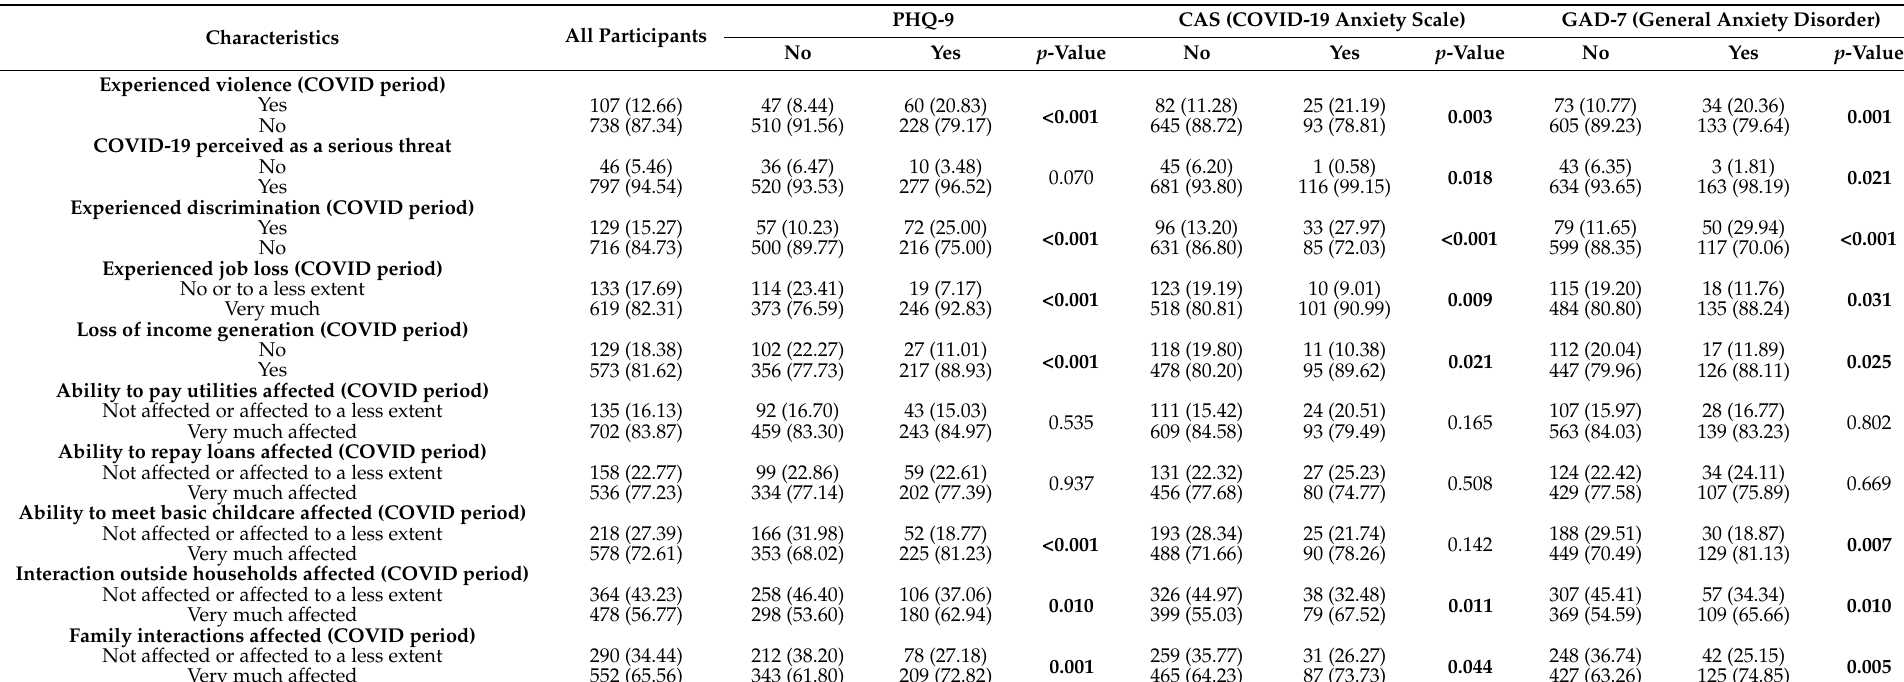
Table 2. COVID-19-related consequences on psychosocial aspects stratified by participants’ mental health scores.